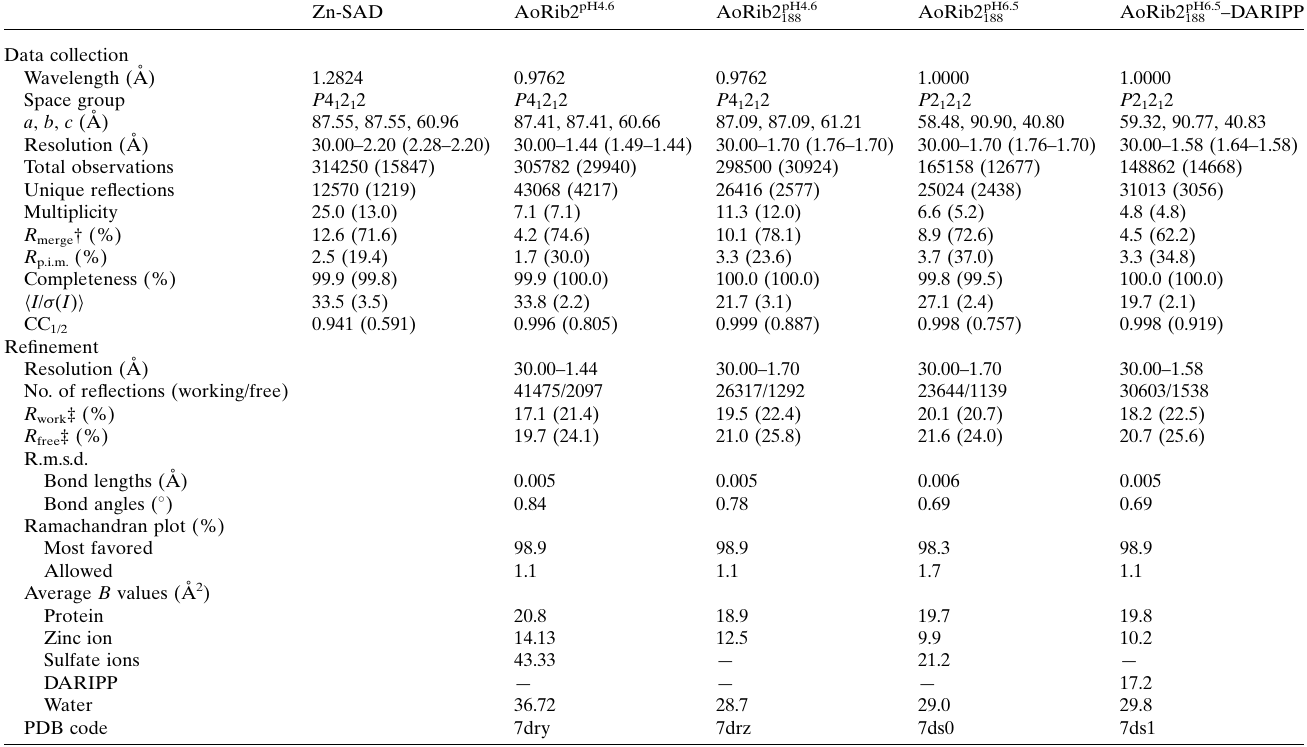
Table 1 X-ray data-collection and refinement statistics. Values in parentheses are for the highest resolution